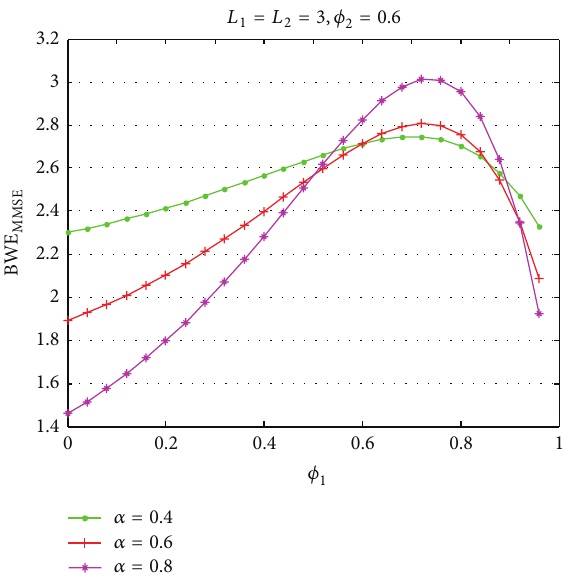
Figure 2: Impact of 𝜙 1 on bullwhip effect for different 𝛼 under the